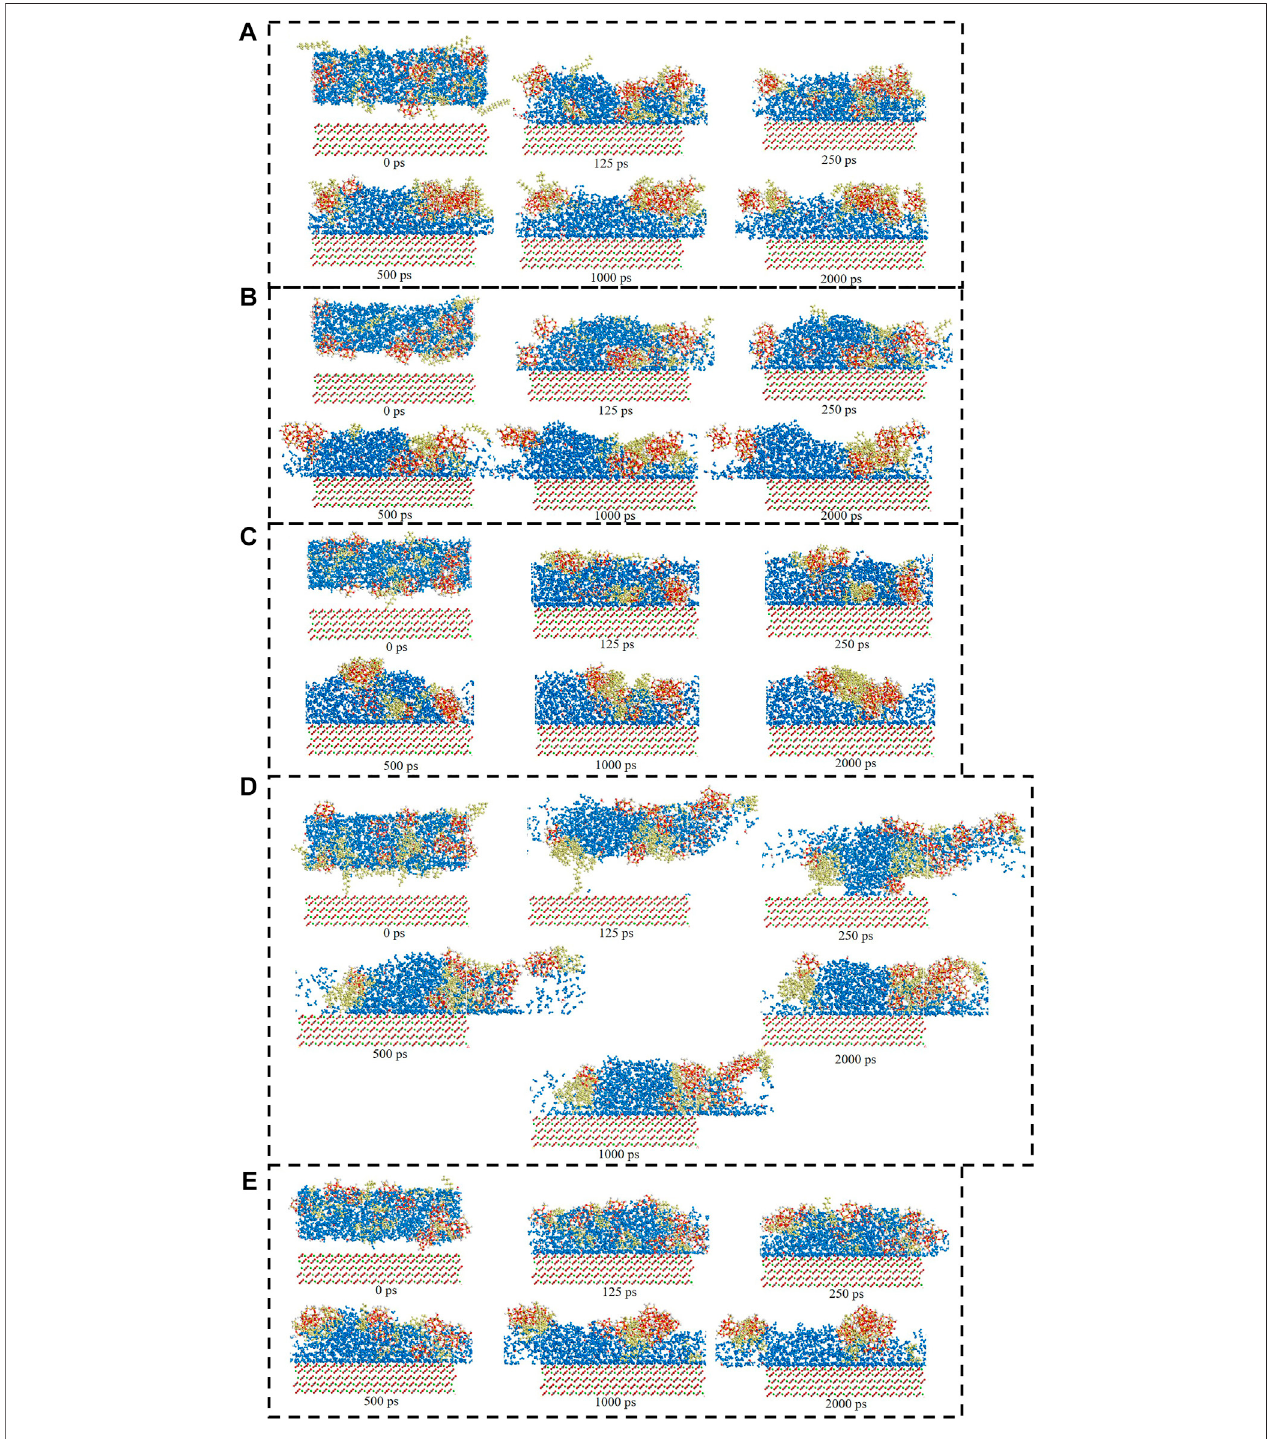
FIGURE 7 | Consecutive snapshot (0 ps – 2000 ps) of (A) CTAB-SiO 2 , (B) SDS-SiO 2 , (C) TX-100-SiO 2 , (D) Sophorolipid-SiO 2 , (E) Rhamnolipid-SiO 2 adsorption onto the modelled calcite surface. yellow = surfactants, red and grey = CO 3 2 − , green = Ca 2+ , red, grey and green = calcite surface, red and white = SiO 2 nanoparticles.